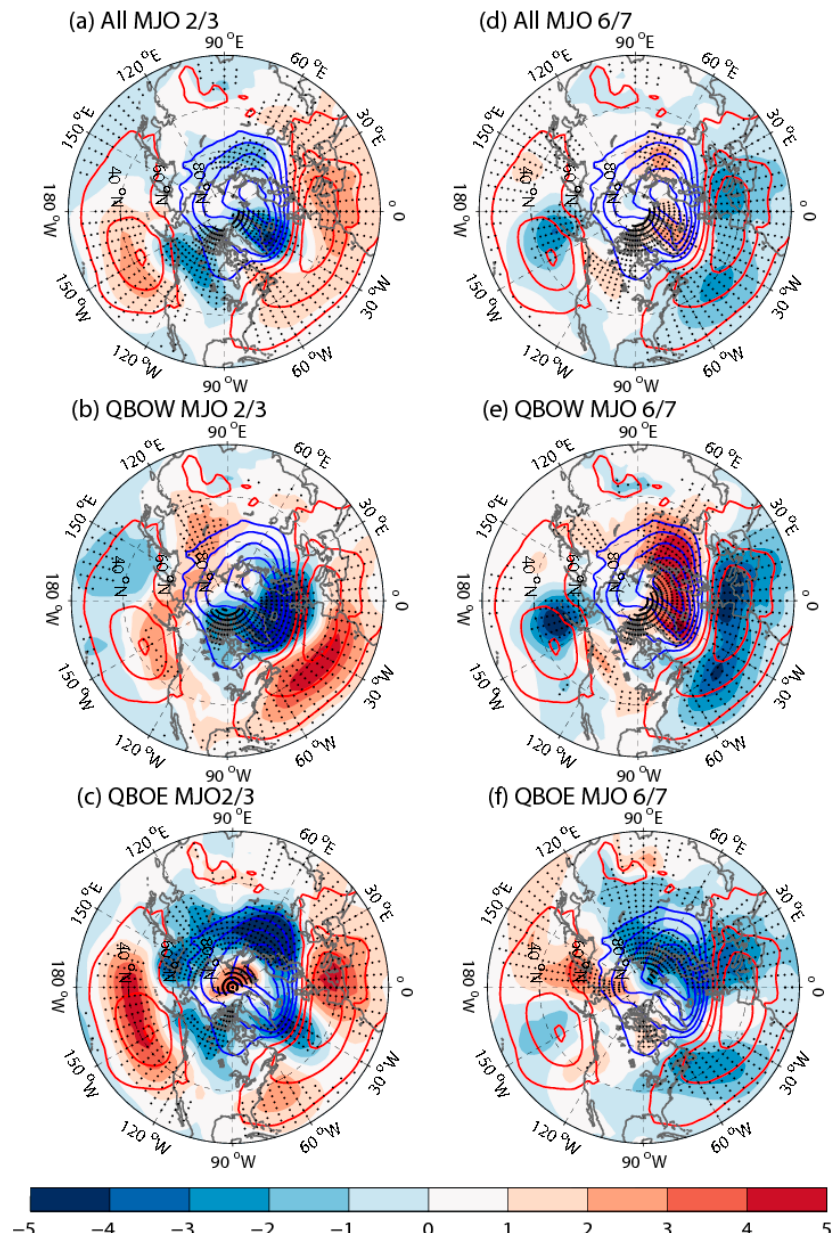
Figure 2. Composite sea level pressure (SLP) anomalies (shading, hPa) averaged from 10 to 14 days after the MJO phase 2/3 in all years ( a ), QBOW ( b ), and QBOE ( c ) years. Subplots ( d )–( f ) are the same as ( a )–( c ) but for the MJO phase 6/7. The black dots indicate anomalies significant at the 95% confidence level by Student’s t test. The red and blue contours denote positive and negative SLP anomalies of the AO pattern.